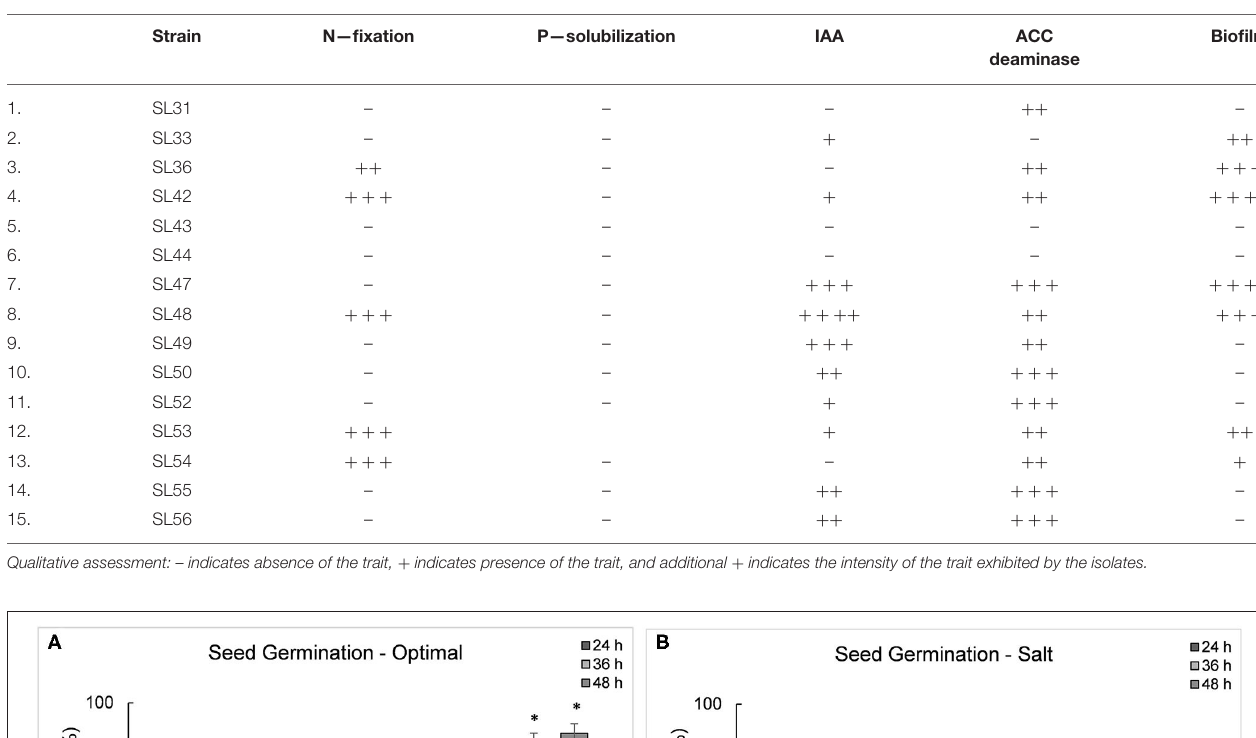
TABLE 1 | PGPR characteristics of the isolated strains characterized using biochemical assays.